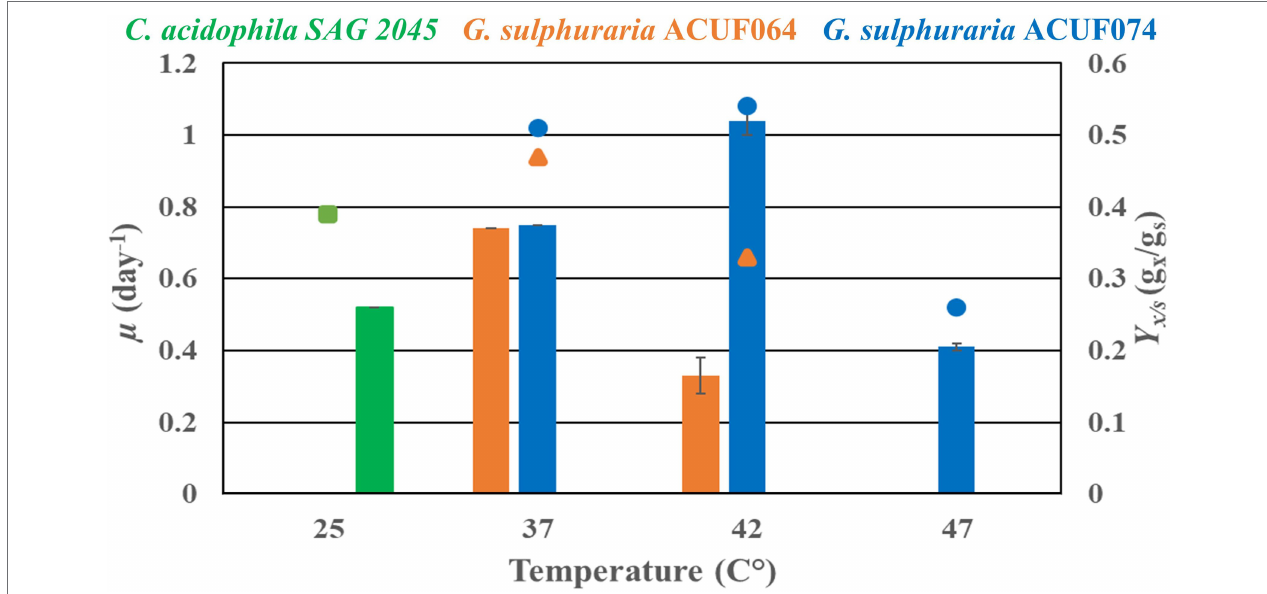
FIGURE 4 | Heterotrophic specific growth rate ( μ ) and biomass yield substrate ( Y x/s ) of Chlamydomonas acidophila SAG 2045 (green), Galdieria sulphuraria ACUF064 (orange), and Galdieria sulphuraria ACUF074 (blue) grown on glucose at different